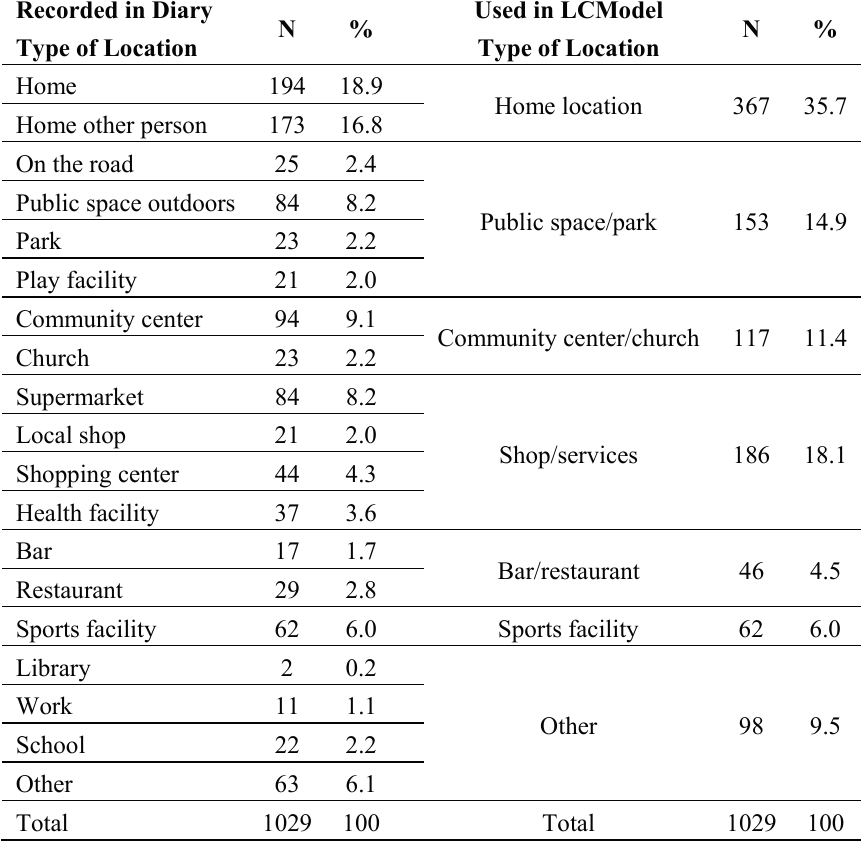
Table 2. Distribution of social interactions across types of